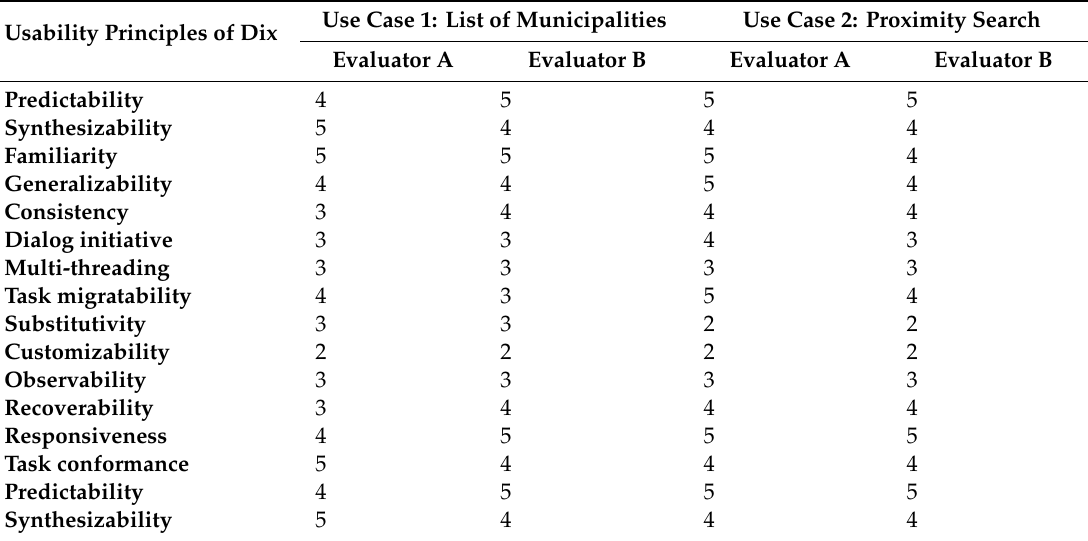
Table 4. Evaluation of the principles of Dix used in the usability audit of the developed